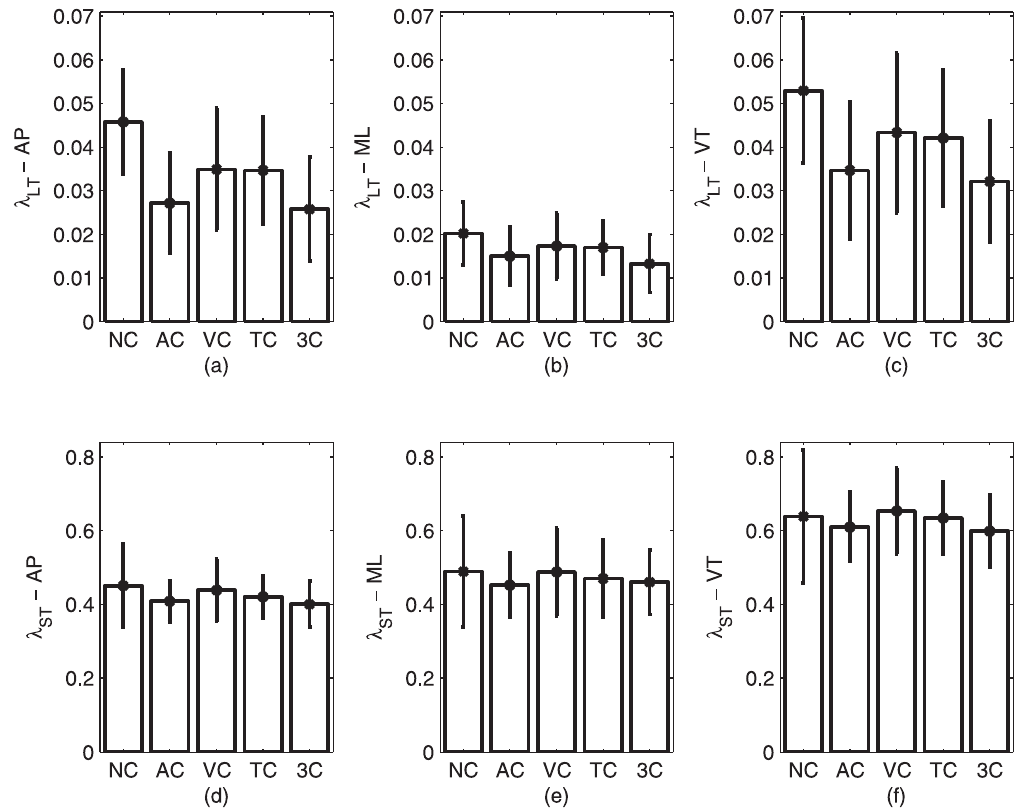
Figure 2. Long and short Lyapunov exponents for the five walking conditions (NC = no cue; AC = auditory cue; VC = visual cue; TC = tactile cue; 3C = three cues). (a) l LT in the AP direction; (b) l LT in the ML direction; (c) l LT in the VT direction; (d) l ST in the AP direction; (e) l ST in the ML direction; and (f) l ST in the VT direction. Error bars denote standard deviation in each case.